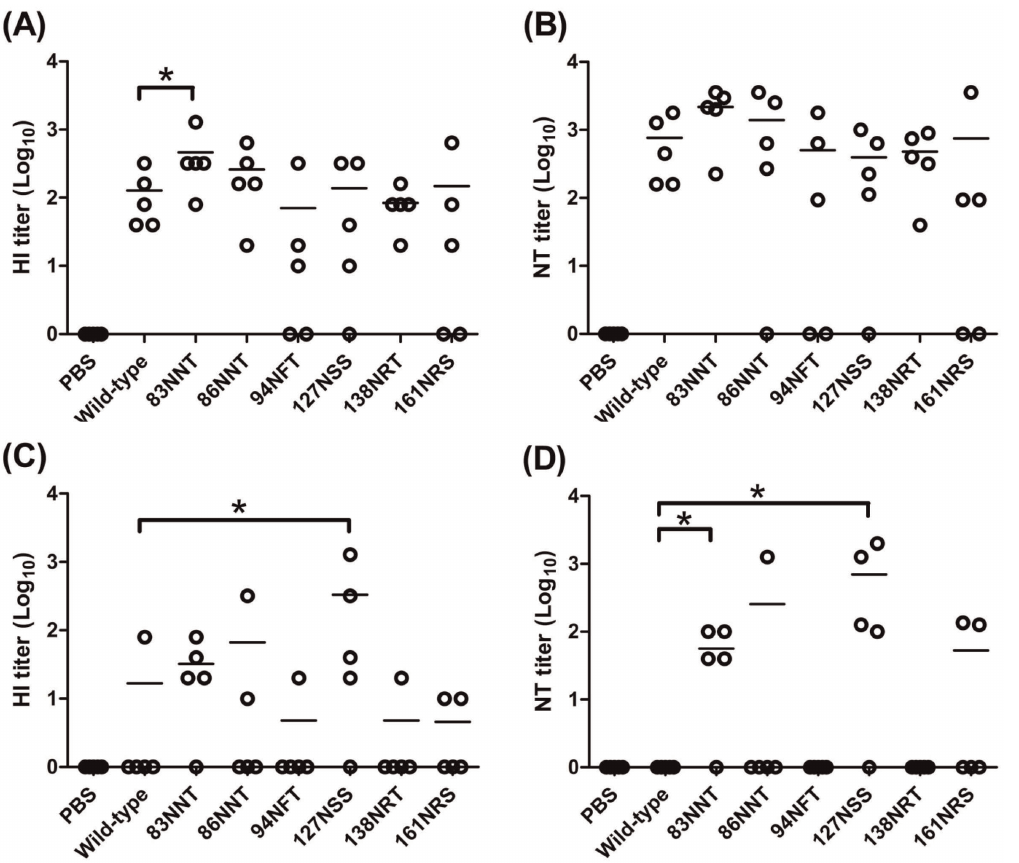
Figure 9. Neutralization against H5pp of A/Anhui/1/2005 and A/Hubei/1/2010 strains. Dose-dependent neutralization curves were plotted against (A) A/Anhui/1/2005 and (B) A/Hubei/1/2010 H5N1 influenza strains. Data indicate that the 83NNT and 127NSS HA mutants elicited higher neutralizing antibodies than the wild-type HA.